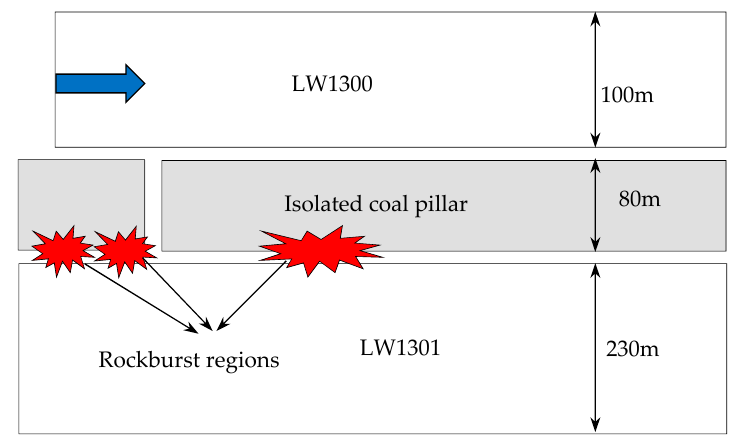
Figure 2. Rockburst regions of Yuncheng Coal Mine.